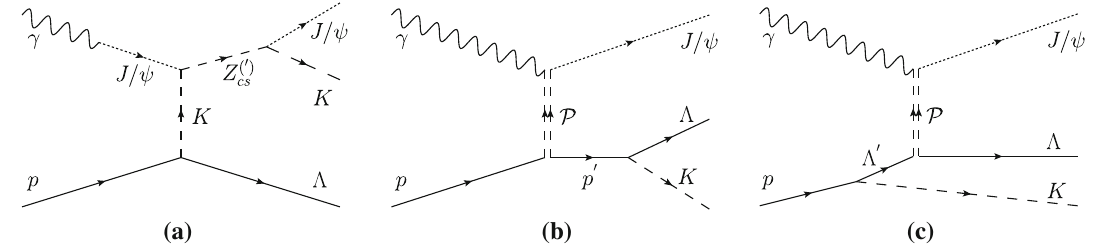
(cid:3) ) diagrams for γ p → ϒ K (cid:3) can be obtained by substituting ϒ for J /ψ cs photopro- ( (cid:3) ) ( (cid:3) ) ( (cid:3) ) /ψ K chan- for Z and Z cs decaying to J cs bs